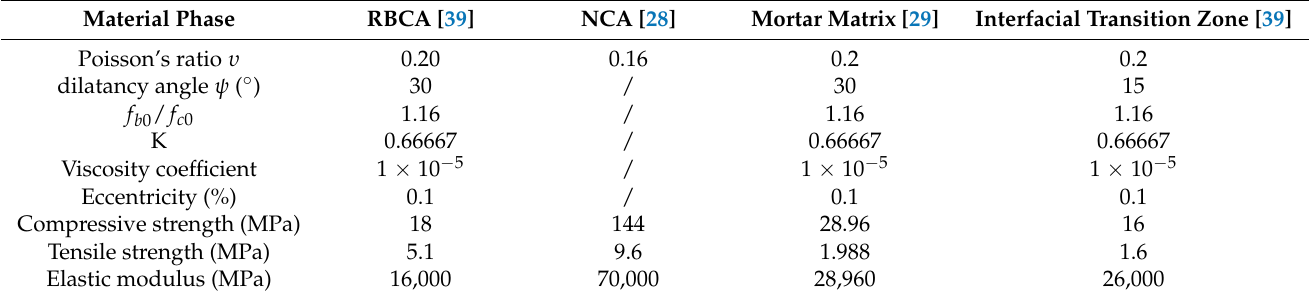
Table 3. Material